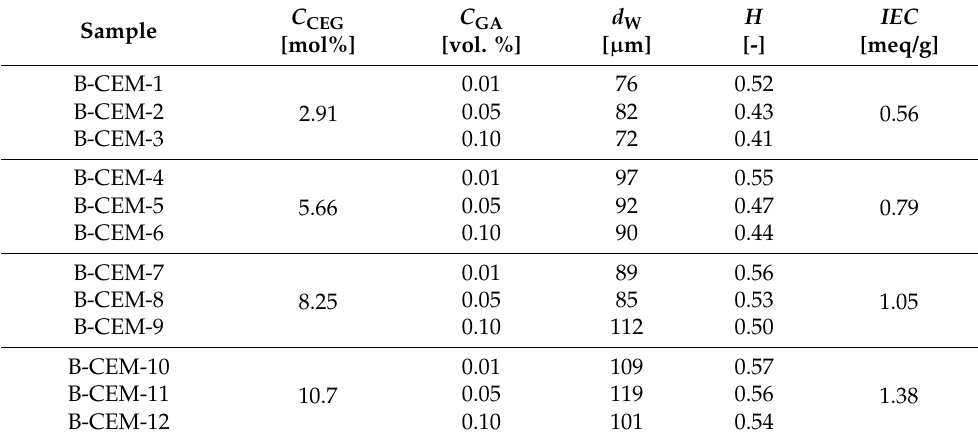
Table 2. Cation-exchange group contents C CEG , GA concentrations C GA for different preparation conditions, thicknesses d W of the wet membranes, water content H , and ion-exchange capacities IEC of B-CEMs. C CEG C GA Sample [mol%] [vol.